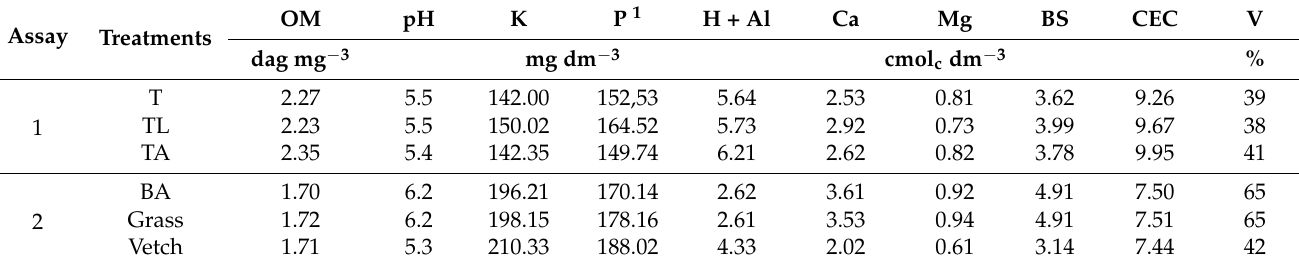
Table 1. Chemical analysis of experimental area soil strips after